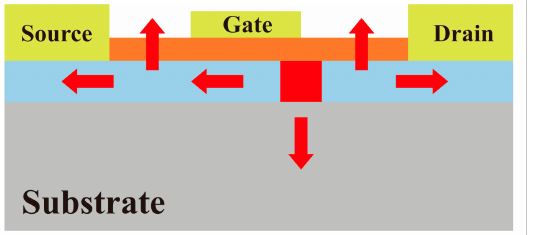
Figure 3. Heat transport model of the simulated β -Ga 2 O 3